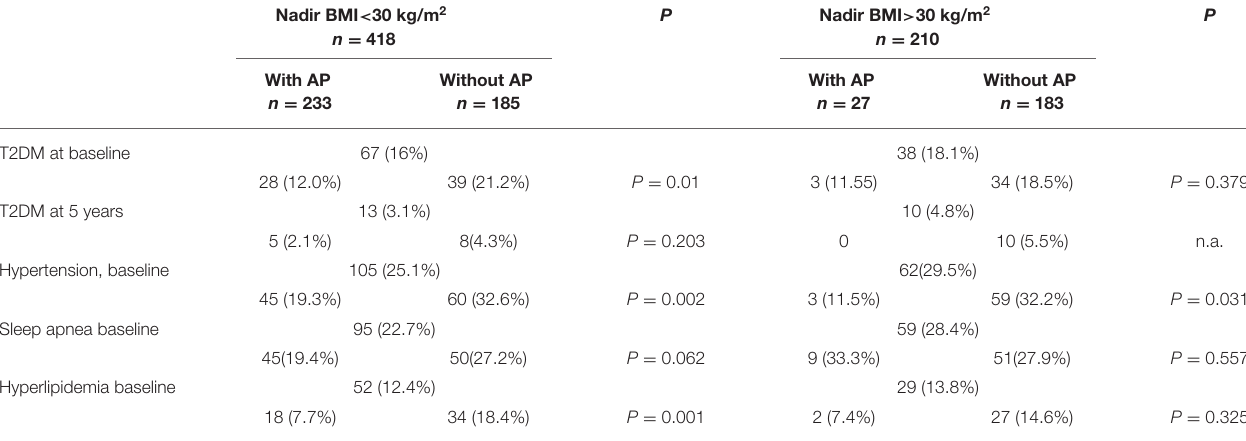
TABLE 1 | Comorbidities at baseline and T2DM status 5 years after RYGB in patients who achieved nadir BMI greater than or less than 30 kg/m 2 , with and without abdominoplasty. Nadir BMI < 30 kg/m 2 n =